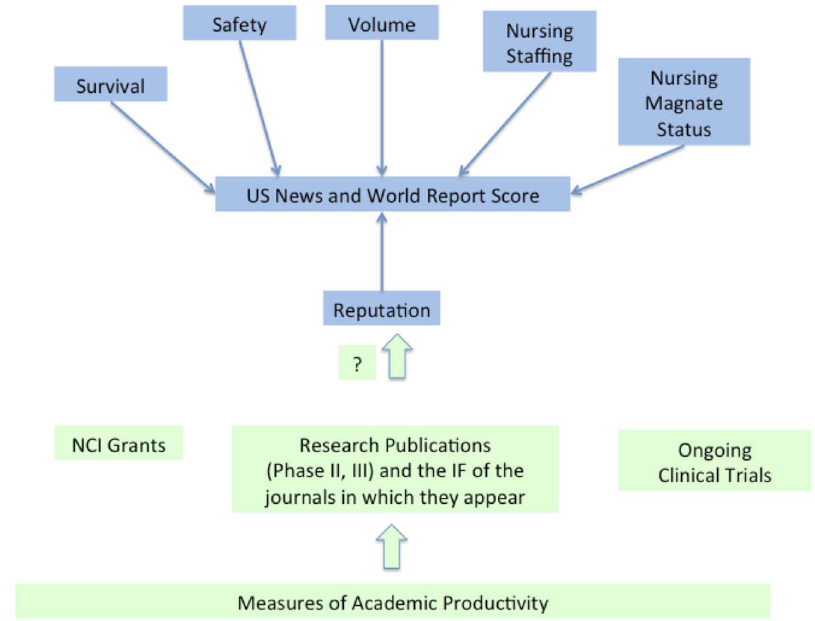
Figure 1. Diagram depicting the US News and World Report Score derivation, and our research question: whether measures of academic productivity correlate with the score.